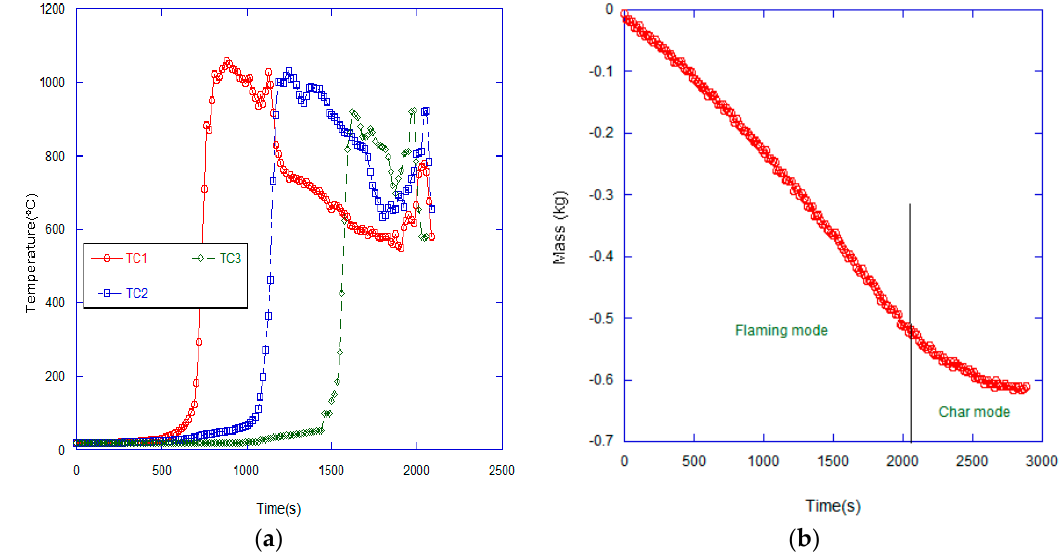
Figure 4. ( a ) Temperature history reported by three thermocouples; and ( b ) mass loss